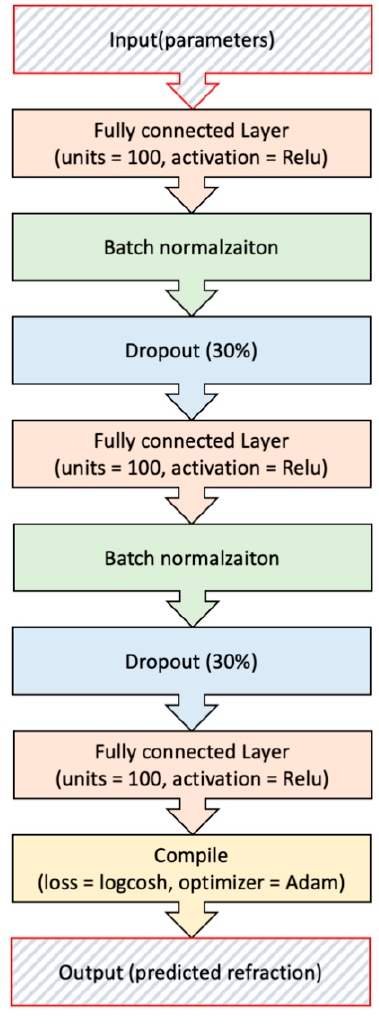
Figure 2. The structure of Neural Network (NN).